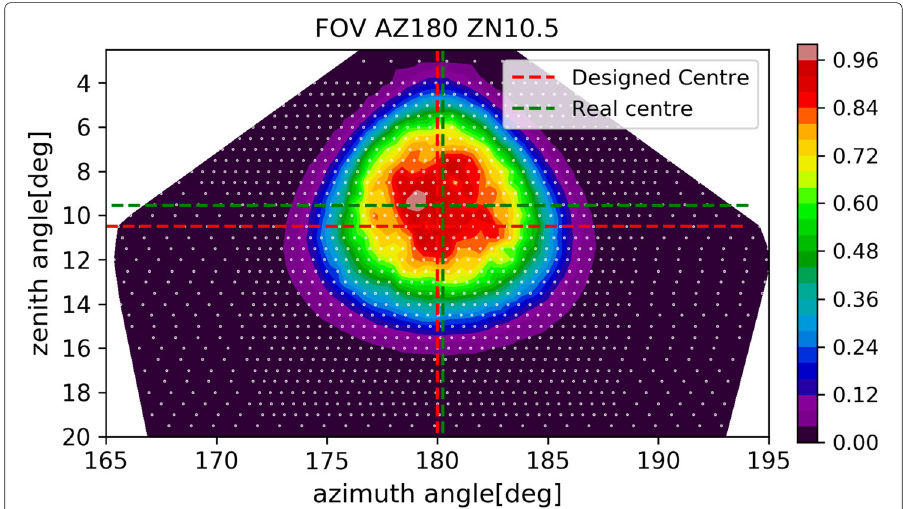
Fig.12 Normalizedradiance(644nmwavelength)measuredthroughtheopticalfibrelocatedat10.5°ZNand 180° AA as a function of the zenith and azimuth angles. White dots represent the position of the lamp over the virtual sphere during the measurement. The intersection of the dotted red lines indicates the expected angular position of the optical fibre. The intersection of the dotted green lines indicates its actual